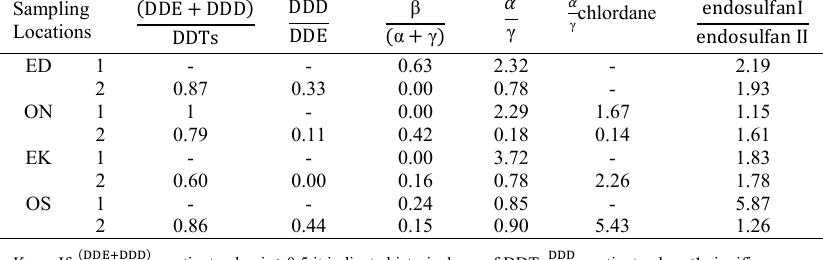
Table 2: Composition quotients of OCPs residues in the study area Sampling Locations